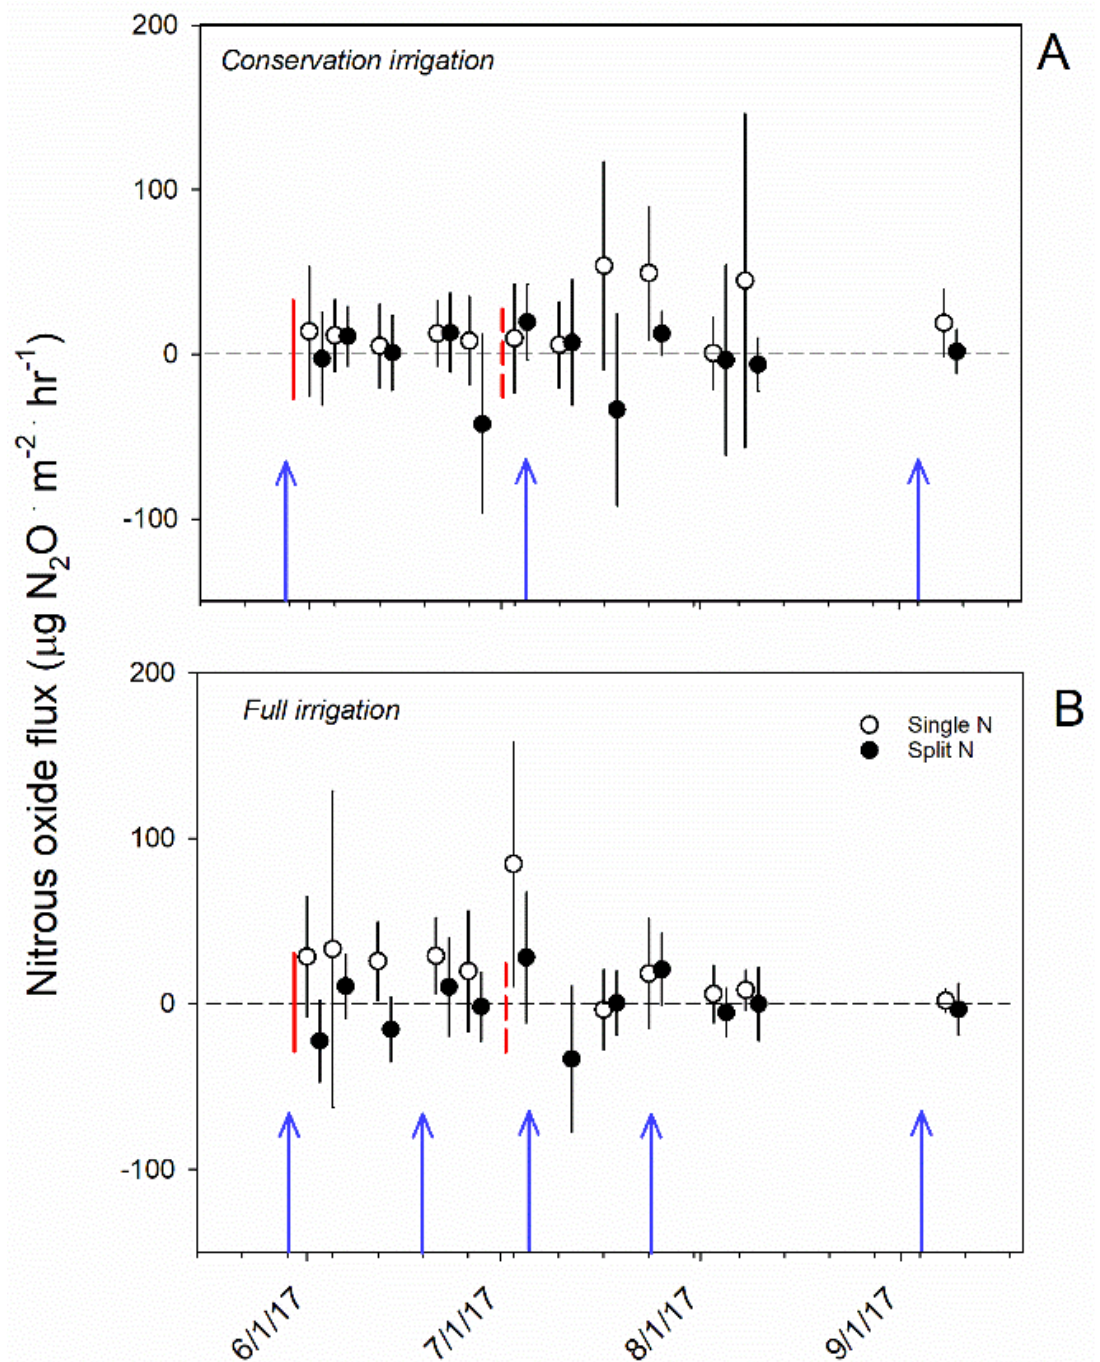
Figure 10. Soil nitrous oxide (N 2 O) flux from a sorghum field under ( A ) 30% less irrigation and ( B ) full irrigation, and with N fertilizer applied once at the start of the growing season or split between two applications. Red vertical lines denote when fertilizer was applied (second application timing for split = dashed line). Blue arrows denote irrigation events. Values are µ g N 2 O · m − 2 · hr − 1 , mean flux per treatment per sample date ± 1